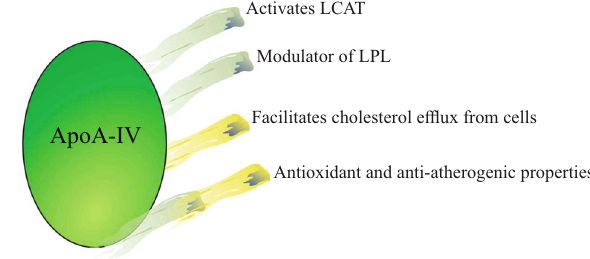
Figure 3: The roles of ApoA-IV. ApoA-IV has antioxidant and antiatherogenic functions. ApoA-IV activates LCAT and modulates LPL activation, favoring cholesteryl ester transfer from HDL to LDL. LCAT: lecithin-cholesterol acyltransferase; LPL: lipoprotein